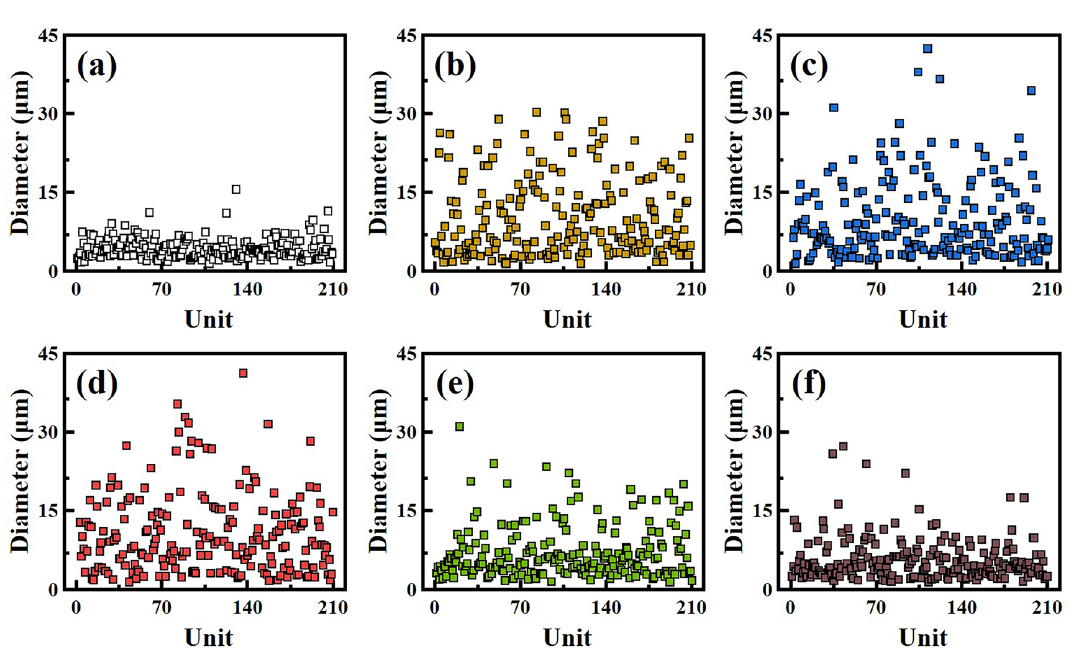
Figure 4. FSF strand diameter distributions obtained at different PSP values. Distributions for ( a ) PSP-134, ( b ) PSP-113, ( c ) PSP-87, ( d ) PSP-76, ( e ) PSP-69, and ( f )